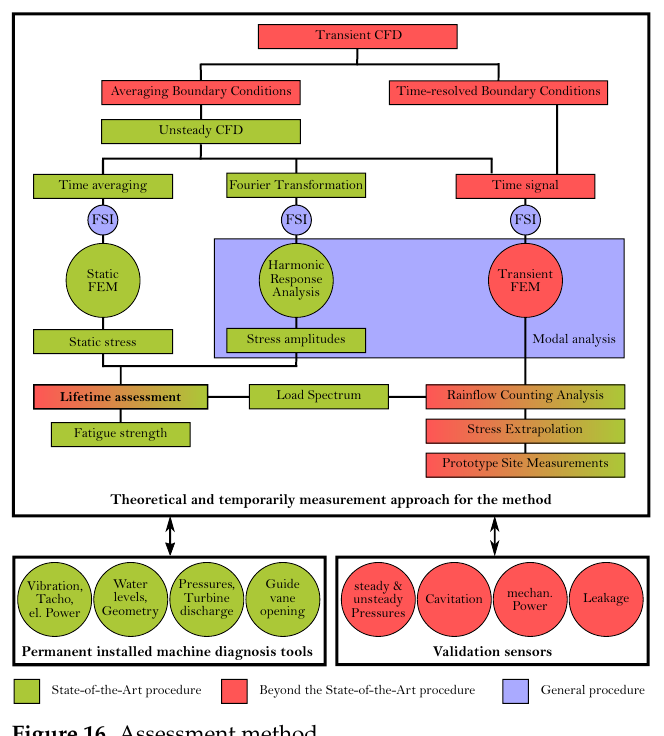
Figure 16. Assessment